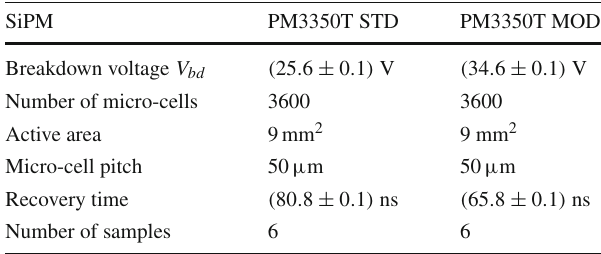
Fig. 3 Sketch of the experimental setup Table 1 List of investigated samples